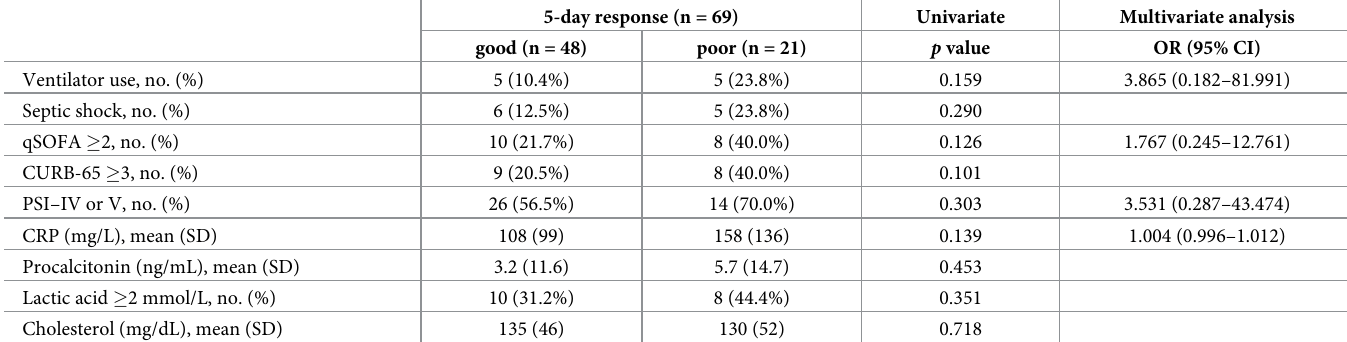
PPSV23 were somewhat higher in CNSP than in CSP. CNSPs accounted for 50% of PCV13 serotypes and 81.2% of PPSV23 serotypes, while CSP accounted for 38.3% of PCV13 serotypes and 48.3% of PPSV23 serotypes (Table 4). PPSV23 serotypes not included in PCV13 showed statistically significantly higher ceftriaxone non-susceptibility (34.4% versus 13.3%, p = 0.018). Specifically, serotypes 19A, 19F, and 11A were more prevalent in the CNSP